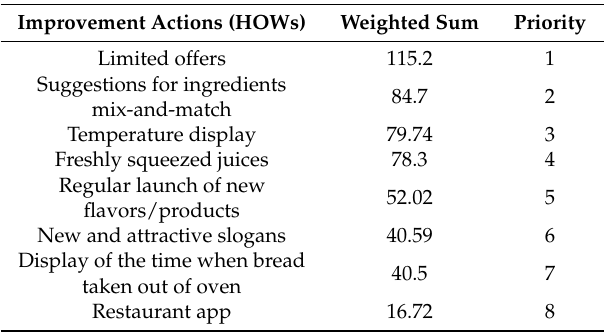
Table 7. Improvement prioritization in house of